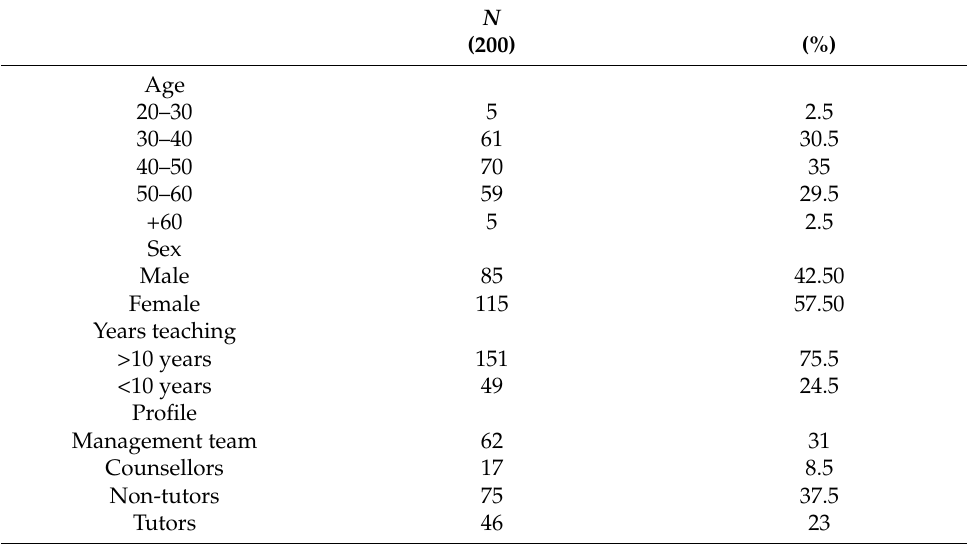
Table 1. Sociodemographic characteristics of informants.